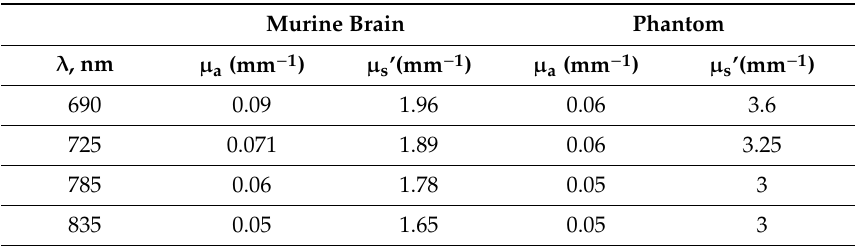
Table 1. Absorption coe ffi cient µ a and reduced scattering coe ffi cient µ s ’ of murine brain ex vivo and of the phantom at the excitation and emission wavelengths of BPD and